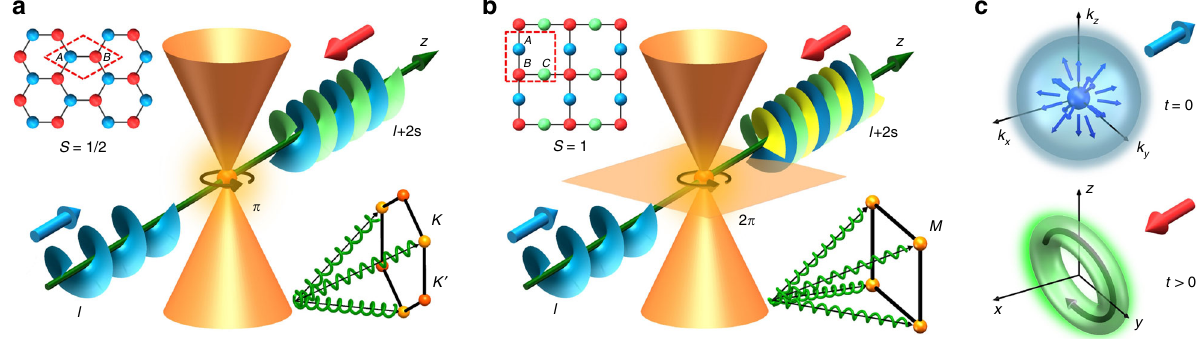
Fig. 1 Illustration of momentum-to-real-space mapping of topological singularities. a A pseudospin-1/2 honeycomb lattice with two sublattices A and B is excited with three vortex beams, each with topological charge l . b A pseudospin-1 Lieb lattice with three sites ( A , B , C ) per unit cell is excited with four vortex beams. These vortex beams excite modes around conical intersections at the corners of the Brillouin zone (lower right inset). The arrows circulating around the conical intersections illustrate winding of the Berry phase ( π in HCL and 2 π in Lieb lattice). Topological charge conversion from l to l + 2 s is a consequence of the mapping of topological singularity from momentum to real space. It occurs when initial excitation with l = ±1 is optimally aligned for a given pseudospin state ( a ) s = ±1/2 in HCL, and ( b ) s = ±1 in Lieb lattice. c Illustration of similar excitation of a Berry curvature monopole in 3D momentum space, leading to generation of a topological charge in real space with vorticity along the direction of excitation. Small blue and red arrows depict opposite pseudospin